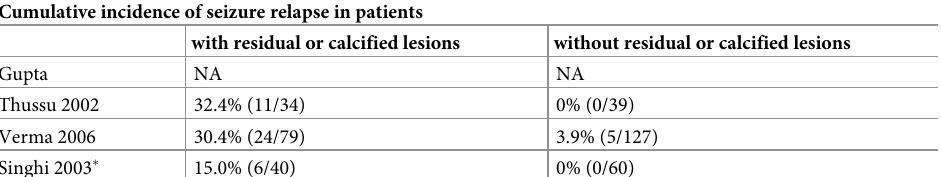
NA: not available � In the study of Singhi et al. 2003 three of the patients included in the numerator had calcified lesions and the other three persistence of lesion. For the 40 patients in the denominator it was not further specified. Thusssu and Verma had only participants with calcification in their denominators.